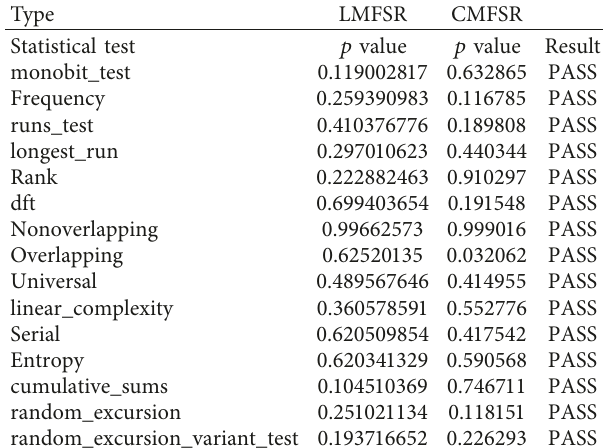
Table 1: NIST result of LMFSR and